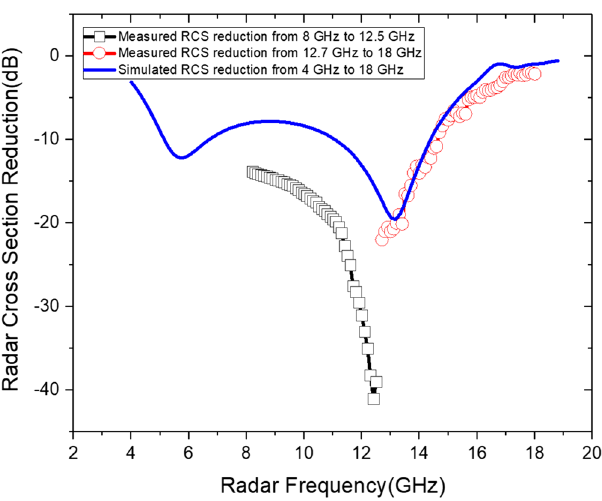
Figure 15. Measured and simulated RCS reduction of the fabricated microwave absorber according to radar frequency.